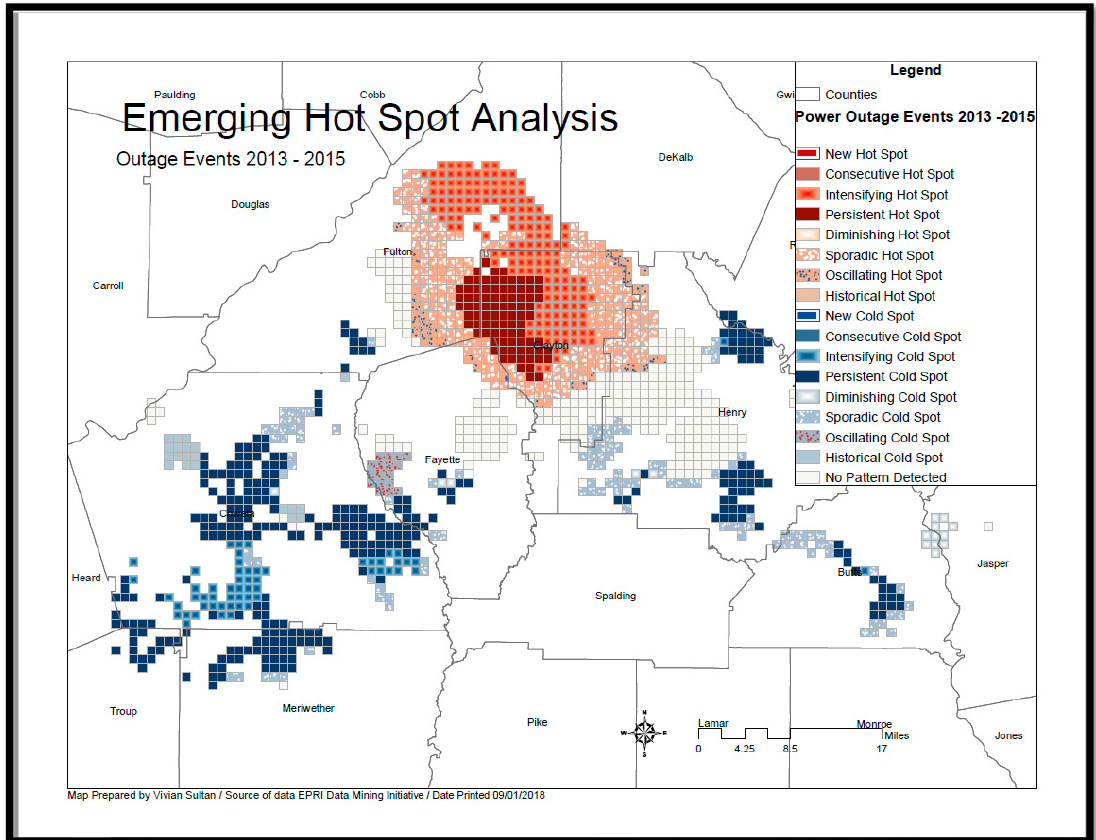
Figure 11. ArcGIS Emerging Hot Spot Analysis Level 1.